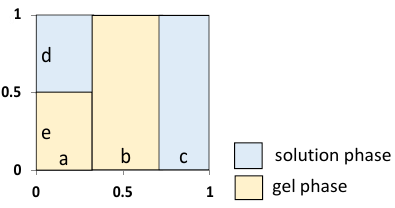
Figure 2. Current transfer paths in an ion-exchange material in an extended three-wire model [30].